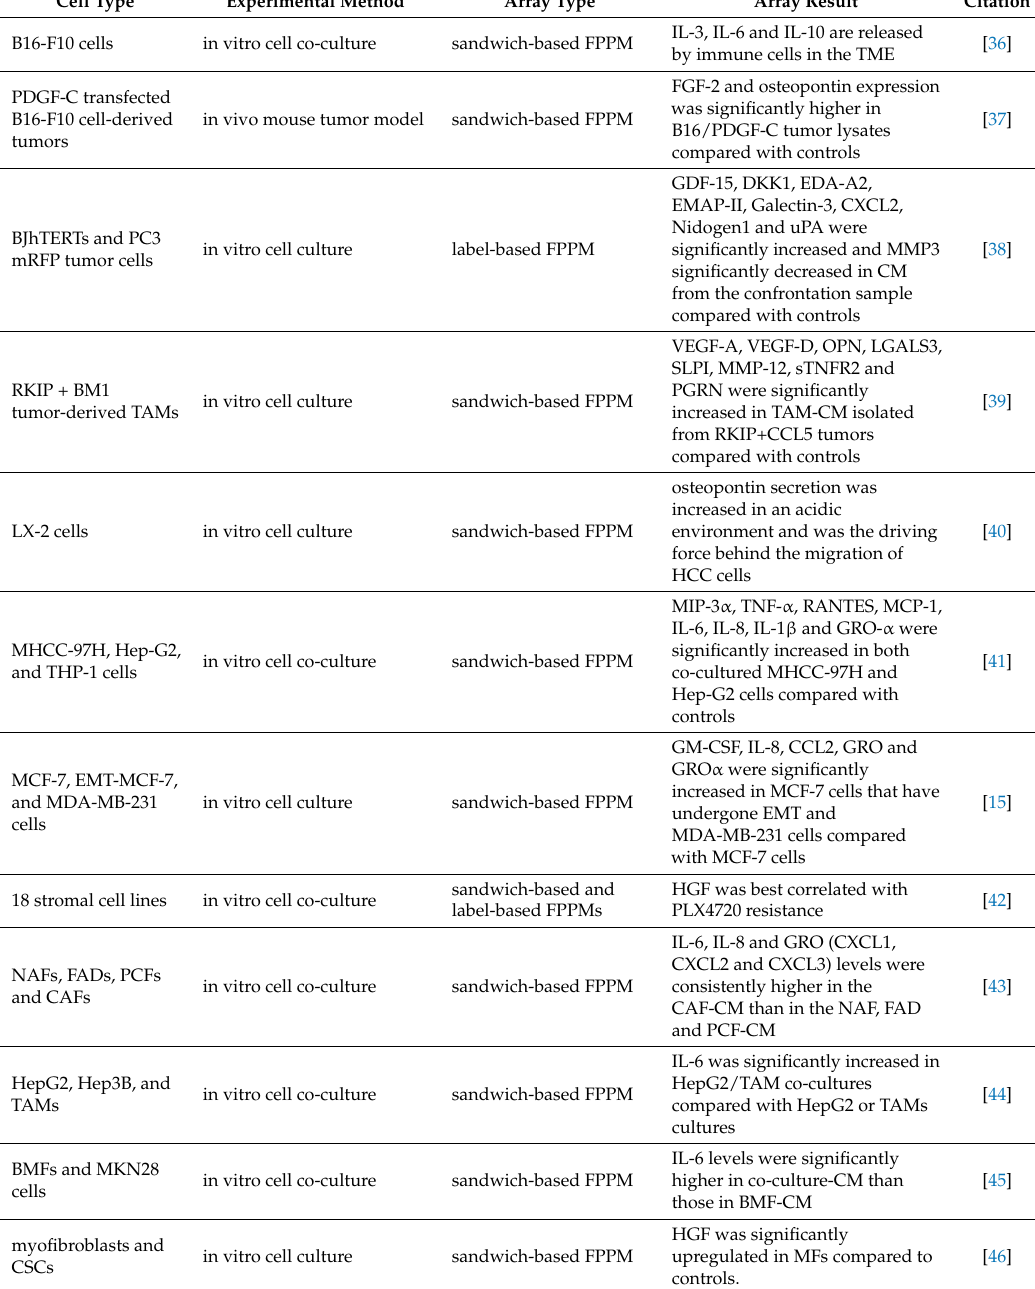
Table 1. Summary of protein arrays used in analysis of the tumor